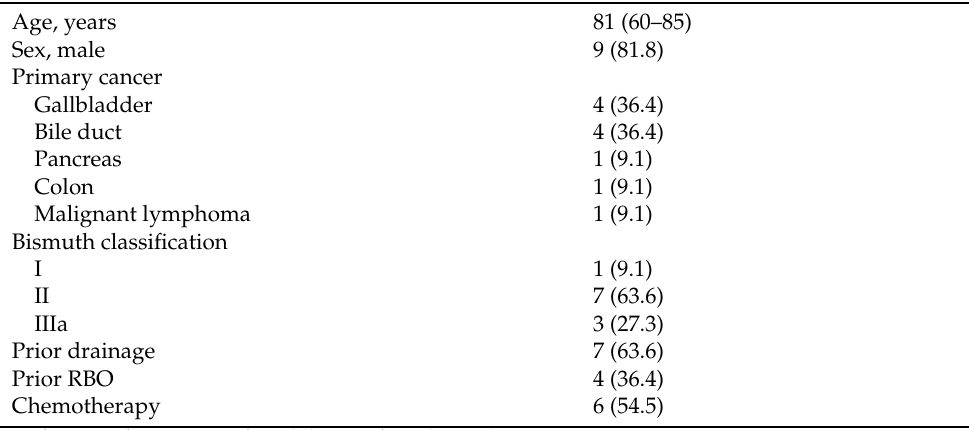
Table 1. Patient characteristics.